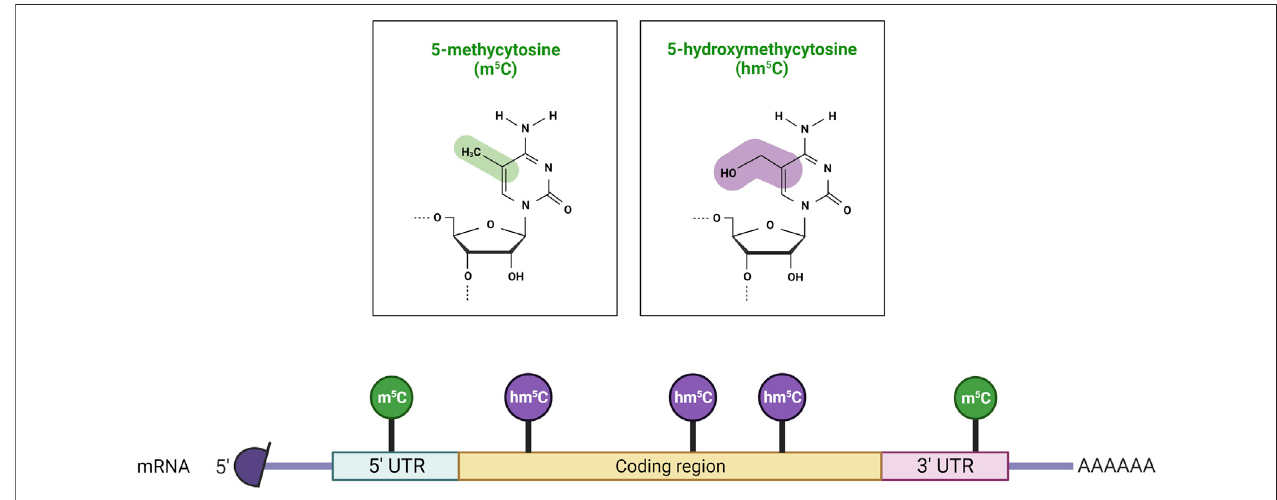
FIGURE 2 | Distribution of m 5 C and hm 5 C post-transcriptional modi fi cations on mRNA molecules. 5-methylcytosine (m 5 C) is predominantly found in 5 ′ untranslated regions (5 ′ UTRs), while 5-hydroxymethylcytosine (hm 5 C) is present within the coding sequence (CDS). Created with BioRender.com.